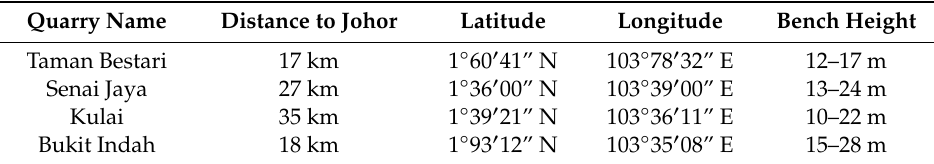
Figure 2. The geological map and locations of studied quarries. Table 1. More information of the studied quarry sites.